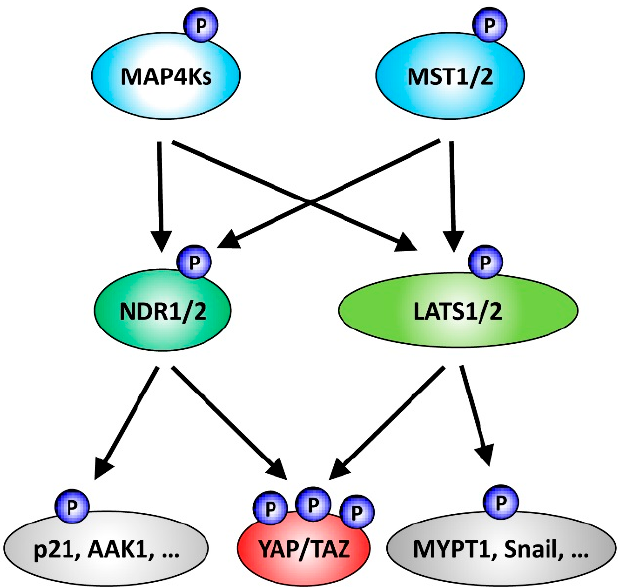
Figure 1. Summary of NDR/LATS kinase signalling functioning downstream of Ste20-like kinases and upstream of the Hippo effectors YAP/TAZ. Classically, the core cassette of the mammalian Hippo pathway includes the Ste20-like serine/threonine protein kinases MST1/2 and the AGC serine/threonine protein kinases LATS1/2. Active MST1/2-LATS1/2 signalling through LATS1/2-mediated phosphorylation of YAP/TAZ can inhibit the transcriptional co-activators YAP and TAZ, two major effectors of Hippo signalling. However, the list of kinases functioning as part of the Hippo core cassette has been expanded recently. In addition to MST1/2, members of the Ste20-like MAP4K kinase family can perform the activating phosphorylation of LATS1/2, consequently resulting in YAP/TAZ inhibition through LATS1/2-mediated phosphorylation. Moreover, the AGC serine/threonine NDR1/2 kinases can act as YAP kinases. Noteworthy, as outlined in more detail in the main text, MAP4K4 can also function upstream of NDR1/2, and NDR1/2 as well as LATS1/2 kinases phosphorylate additional substrates besides YAP.